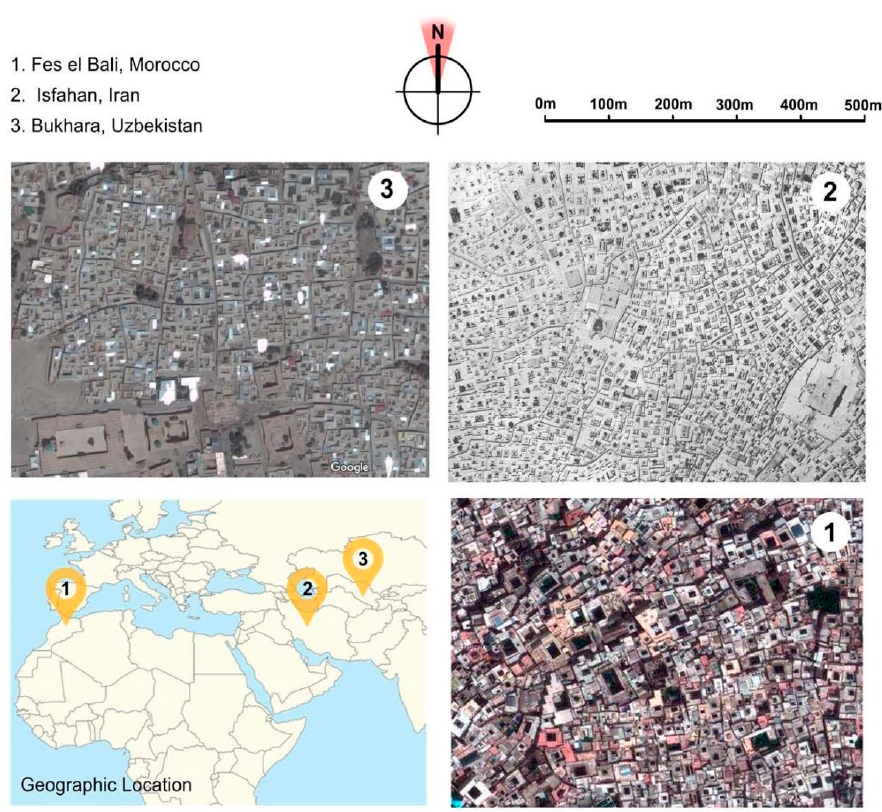
Figure 4. The morphology of courtyard structures in Middle Eastern and North African cities [31] .